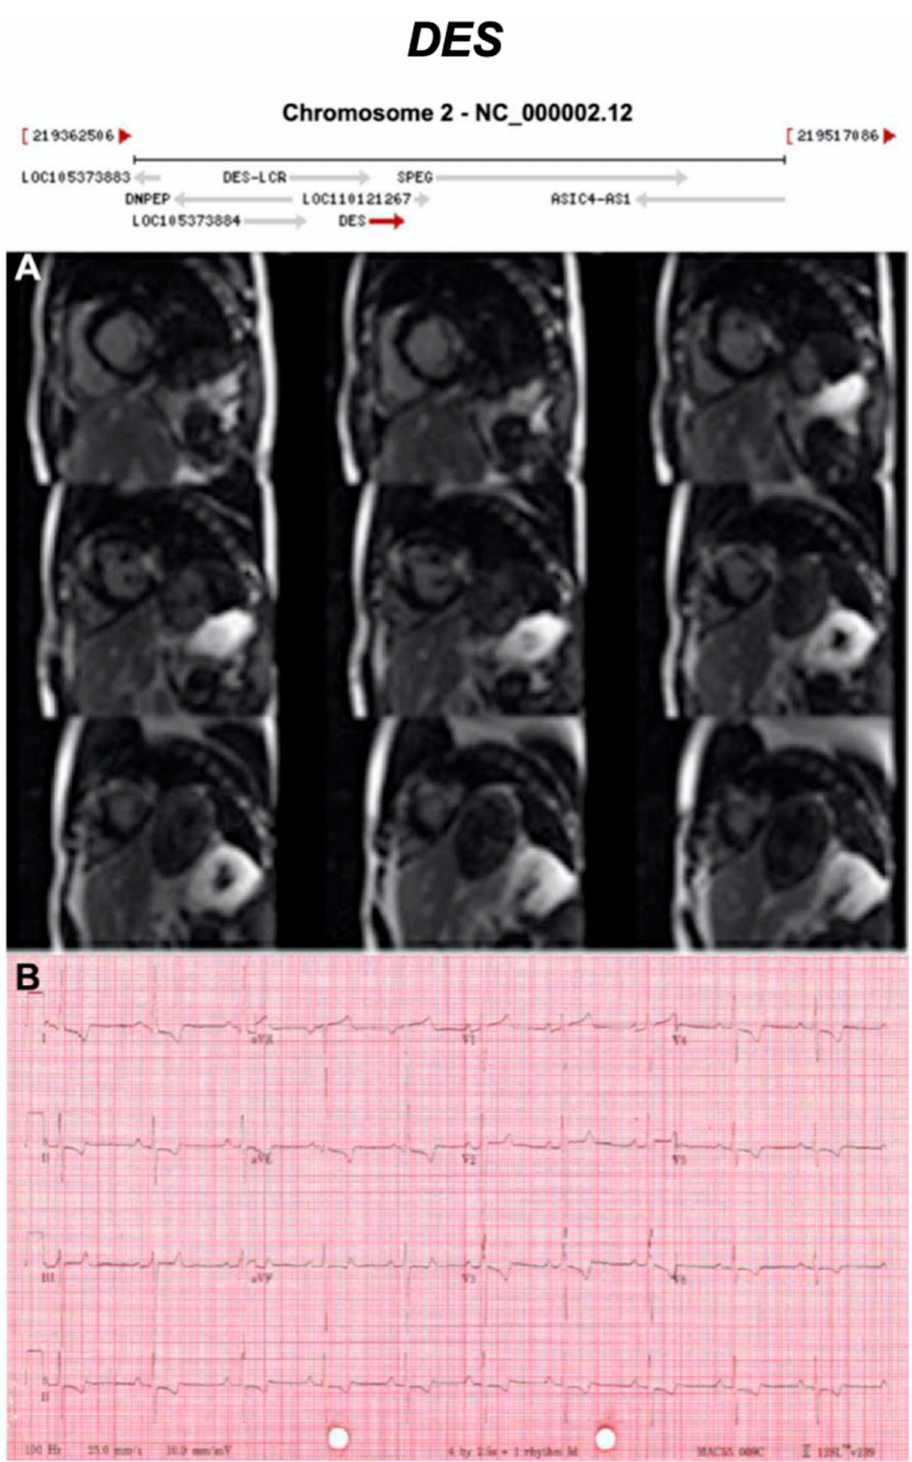
Figure 11. Exemplar MRI and ECG finding found in ACM patients with DES mutations. ( A ) CMR of a patient with DES mutation (deletion of guanine at position 735) showing extensive mid-wall fibrosis (LGE short-axis view); ( B ) 12-lead ECG of a di ff erent patient with p.Gly382Val mutation of the LMNA gene showing sinus tachycardia, inverted T waves in V1–V3 ad poor R wave progression. Reproduced from Koitka et al. (2017) with permission